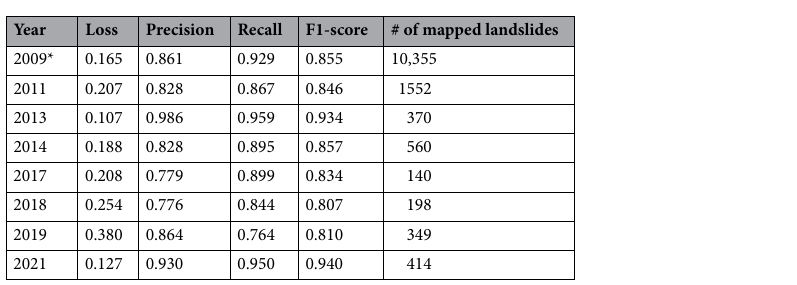
Table 2. Accuracy of mapped landslides in time in Wenchuan, China. * Co-seismic event